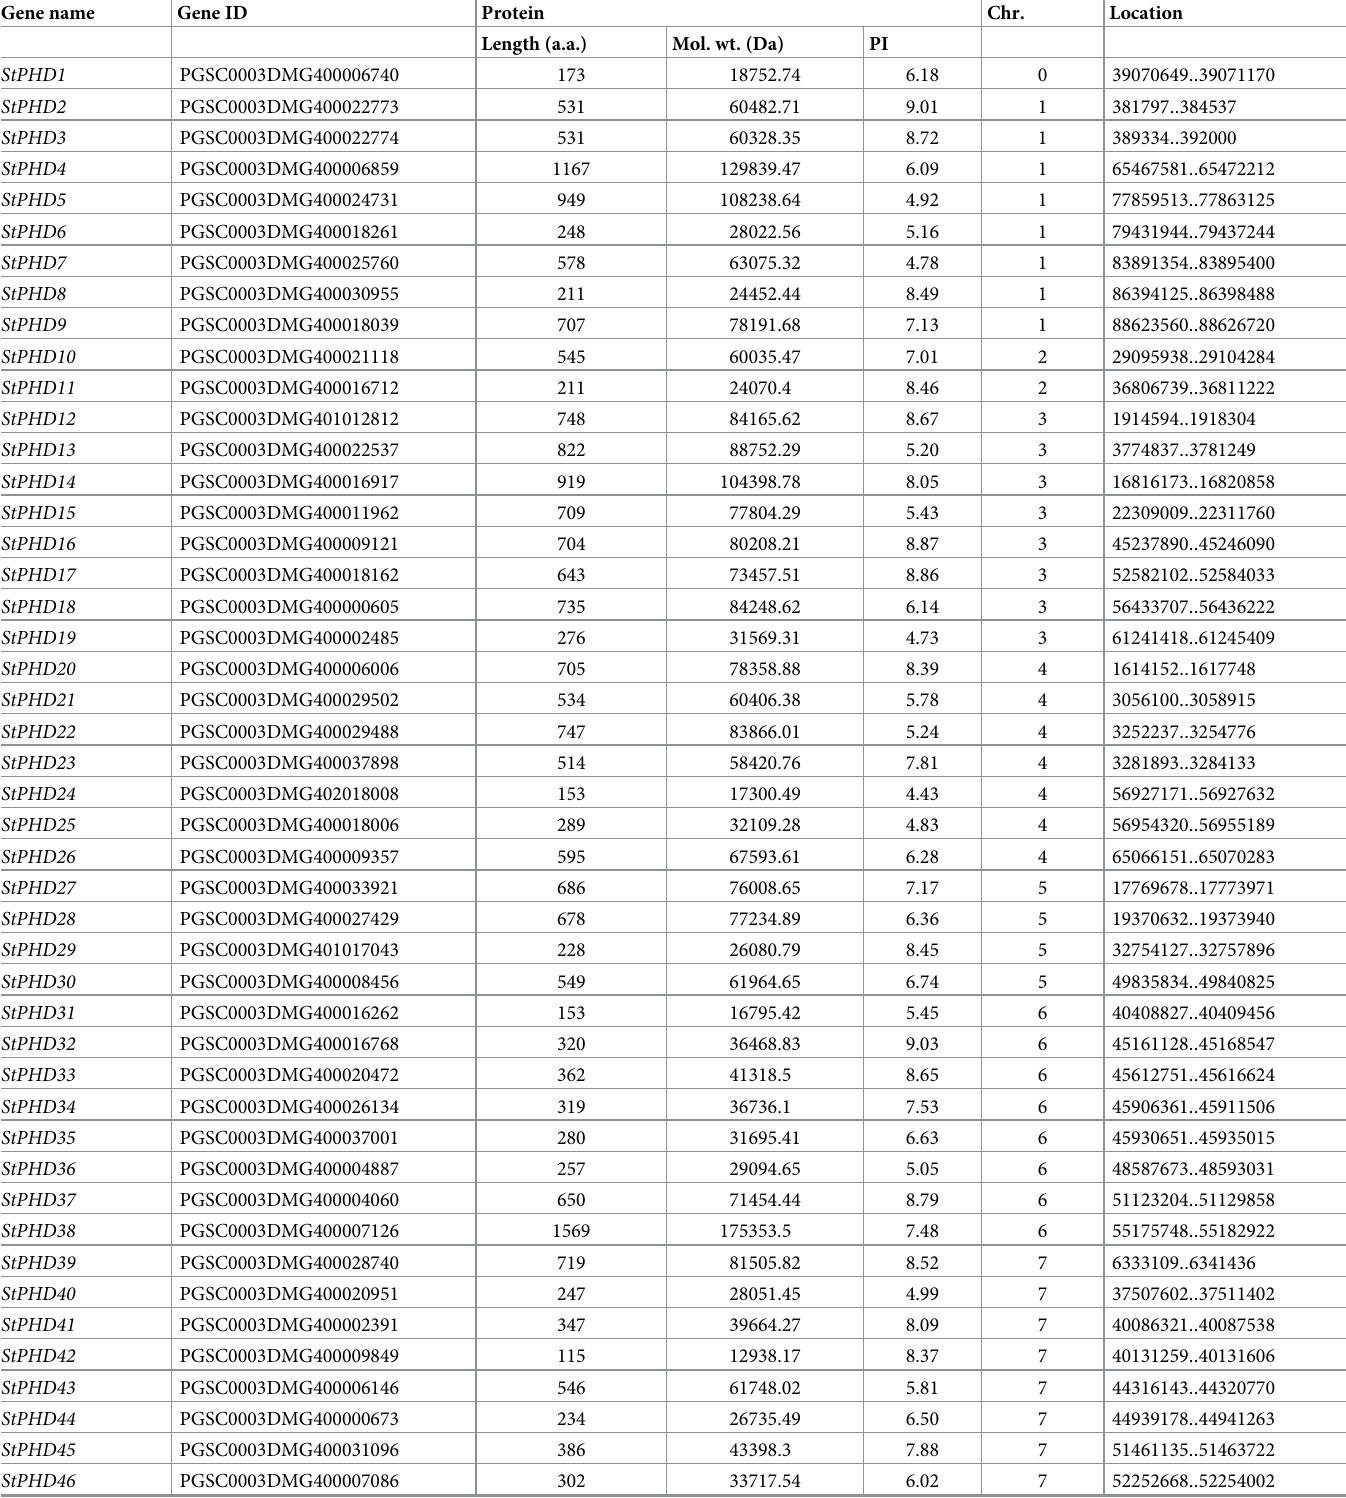
Table 1. The PHD family genes in Solanum tuberosum